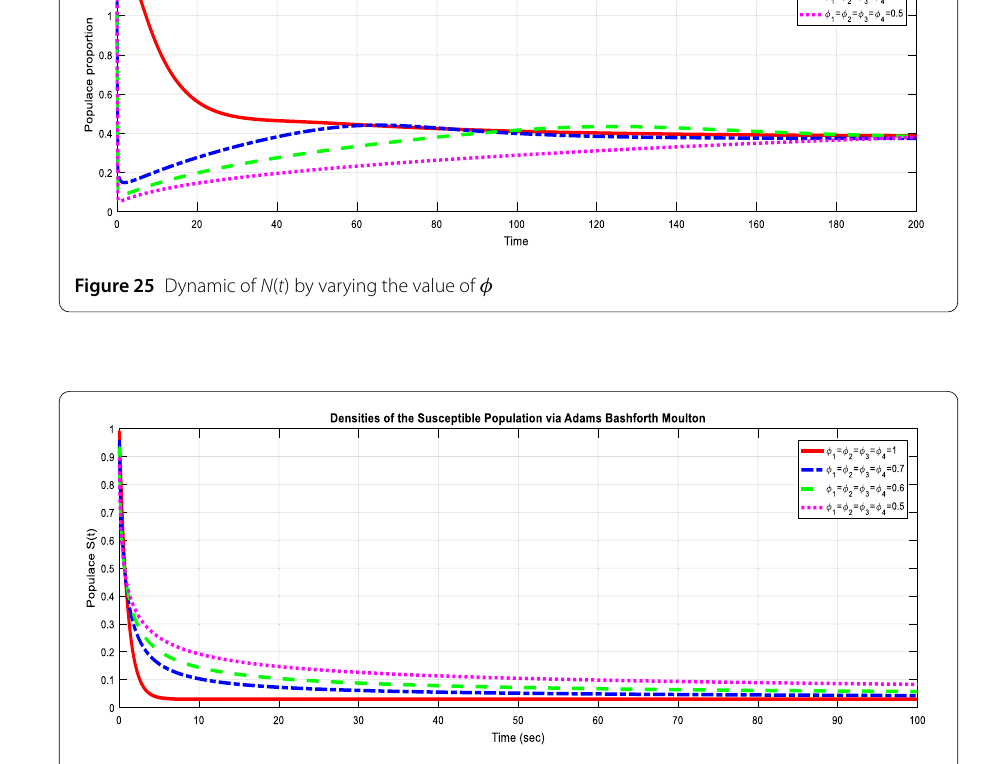
Figure 26 Dynamic of populace S ( t ) by varying the value of